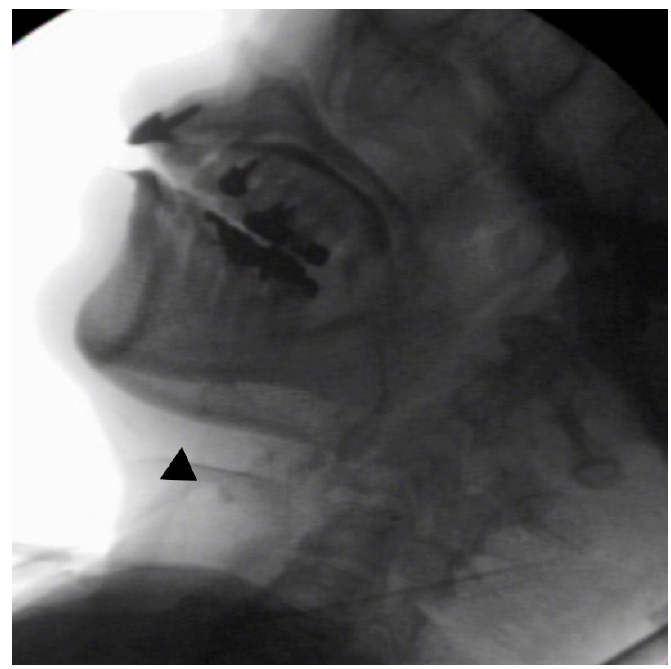
Figure 4. The patient was reclined at 30° for the administration of 5 mL of a moderately thick paste. There was delayed triggering of the swallowing reflex; moreover, silent aspiration occurred ( ▲ ).